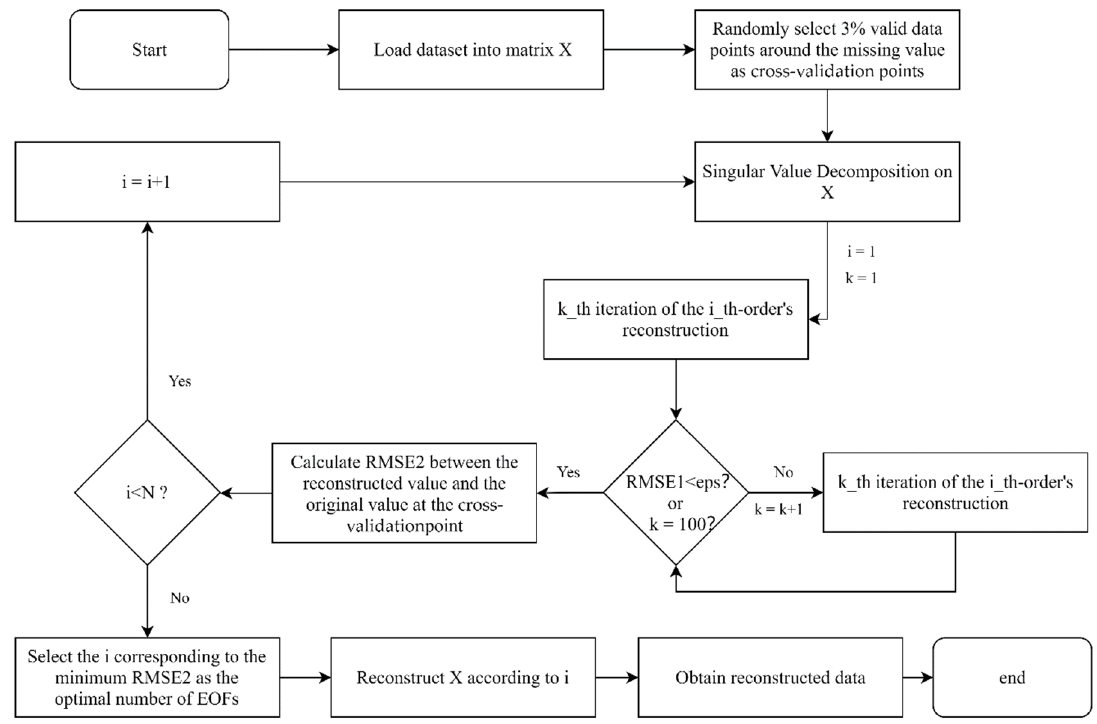
Figure 2. Flow chart of IV − DINEOF algorithm.